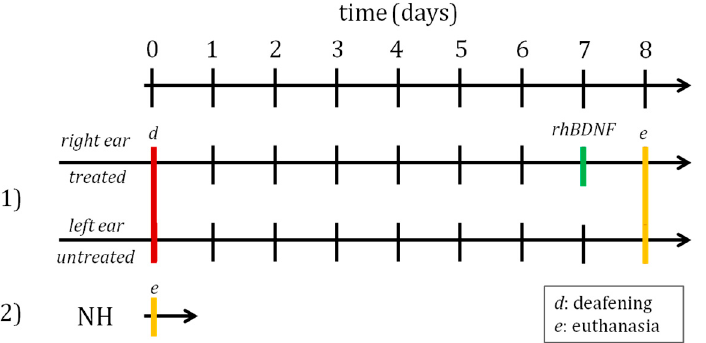
Figure 2. Schematic Illustration of the experimental design. Group 1 of guinea pigs underwent the deafening procedure; the right ear was treated after 7 days from the injury, while the left ear was left untreated; the animals were euthanized 8 days after deafening. Group 2 is formed by normal-hearing (NH) guinea